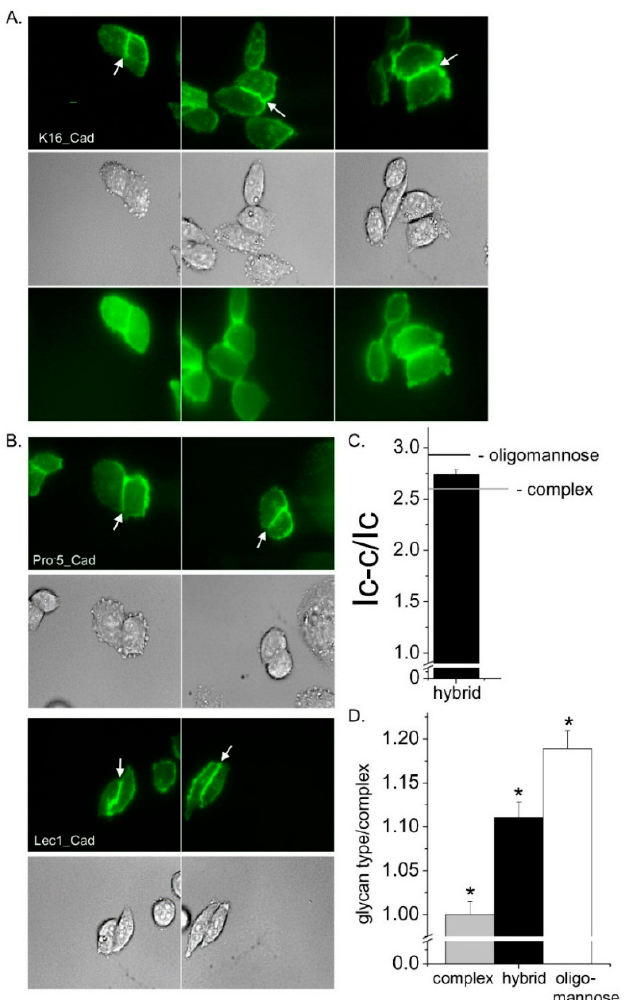
Figure 6. Predominant expression of hybrid N -glycans impacts the localization of E-cadherin at the cell–cell border in a different manner than predominantly expressed complex or oligomannose N -glycans. Microscopy images were acquired in TIRF ( upper panels ), wide-field ( middle panes ), and DIC ( lower panels ) modes for EGFP tagged E-cadherin expressed in K16 cell line ( A ). To directly compare the localization of E-cadherin to the cell–cell interface with complex and oligomannose N -glycans, TIRF ( upper panels ) and DIC ( lower panels ) images were also acquired for E-cadherin transfected Pro − 5 and Lec1 cell lines ( B ); Representative scale bar (5 µM) was same for all images. Cell–cell interface is denoted by white arrows. Fluorescence intensity measurements were ascertained at the cell–cell interface (I cell–cell ), and away from the cell–cell interface (I cell ) of the cell membrane patch to determine the amount of E-cadherin at cell–cell border relative to that away from the cell–cell border (I cell–cell /I cell ). The bar on the graph reports the I cell–cell /I cell mean value of E-cadherin expressed in the K16 cell line while the lines designated as complex and oligomannose are the mean values for E-cadherin expressed in Pro − 5 and Lec1 cell lines, respectively ( C ); The ratio of I cell–cell /I cell value for a given N -glycan type to complex type of N -glycan illustrates differences in the spatial arrangement of E-cadherin expressed with different predominant N -glycan types ( D ). At the p < 0.01 level, the differences of the population means are significantly different by one-way ANOVA with Bonferroni adjustment (*).